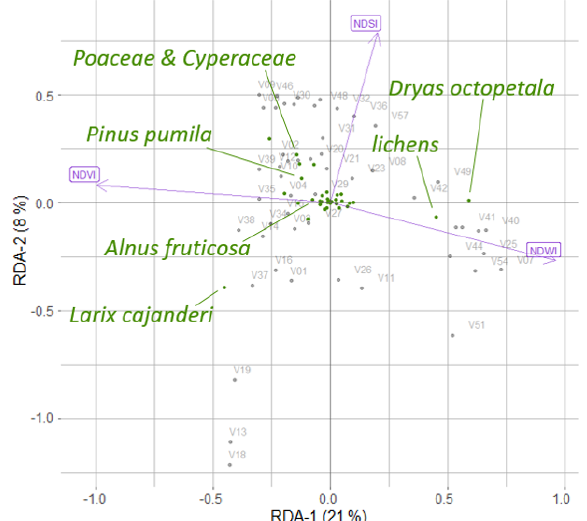
Figure B1. The positions of the major taxa in the RDA space, based on foliage projective cover data of the plot taxa and Landsat spectral indices (normalised difference vegetation index (NDVI), normalised difference water index (NDWI), and normalised difference snow index (NDSI)), where V01–V58 are the 52 vegetation field sites (Shevtsova et al., 2020a).